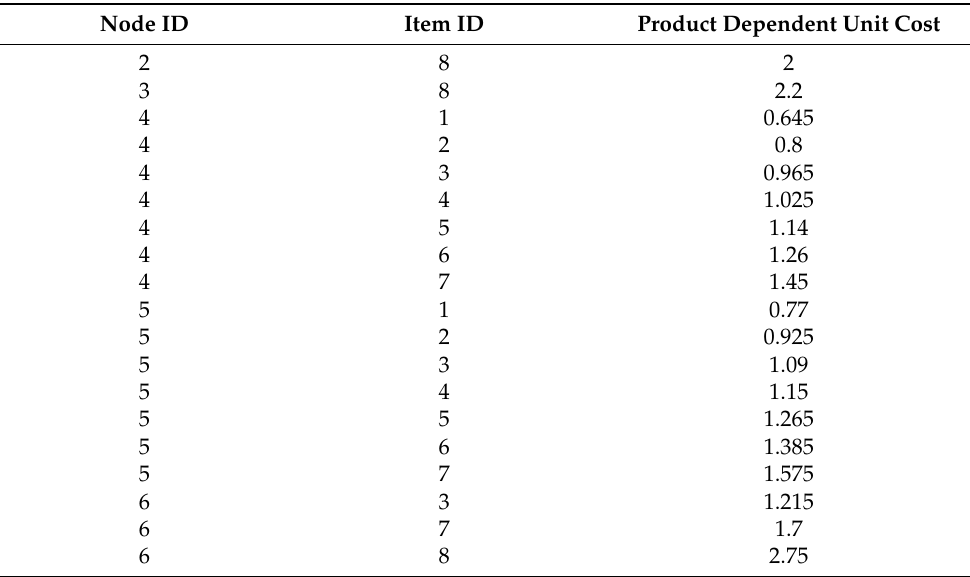
Table 4. Product-dependent unit cost in all intermediate nodes per time